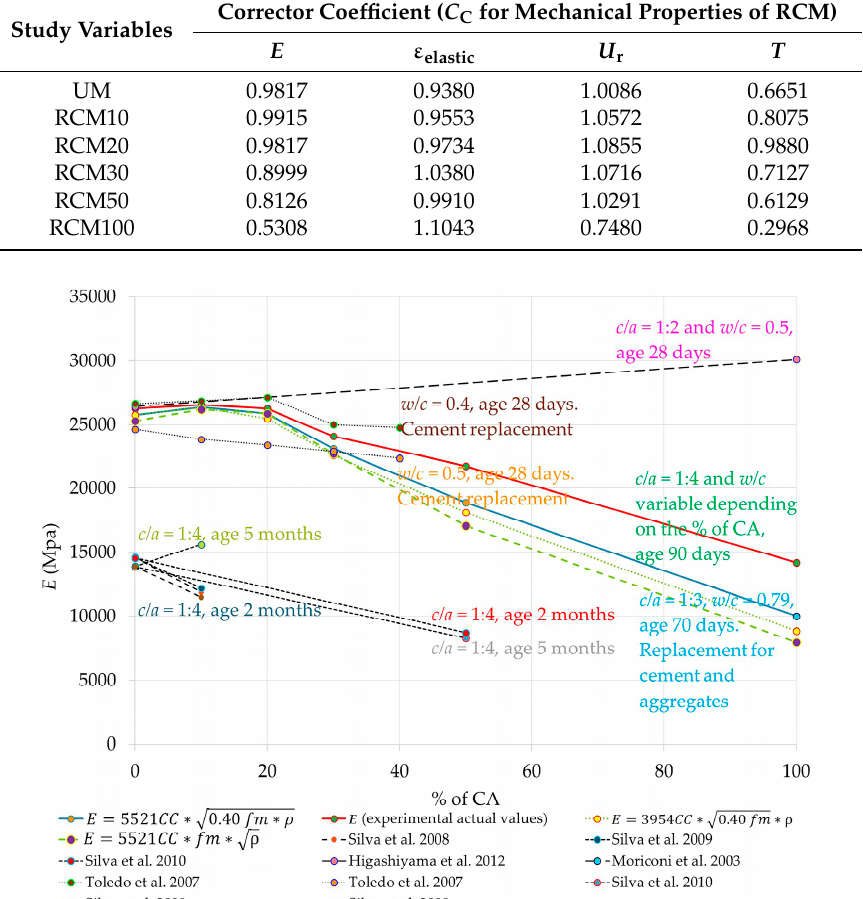
Figure 11. E prediction equation for RCM confronted with real experimental data, and reported in other investigations.